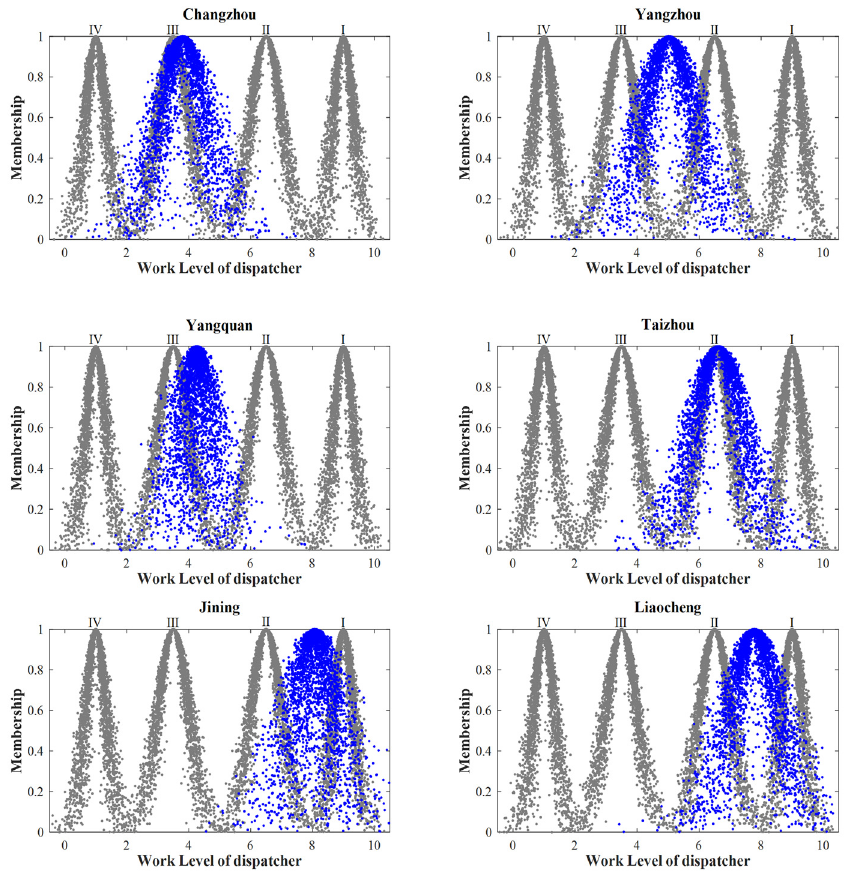
Figure 4. Cloud map of evaluation